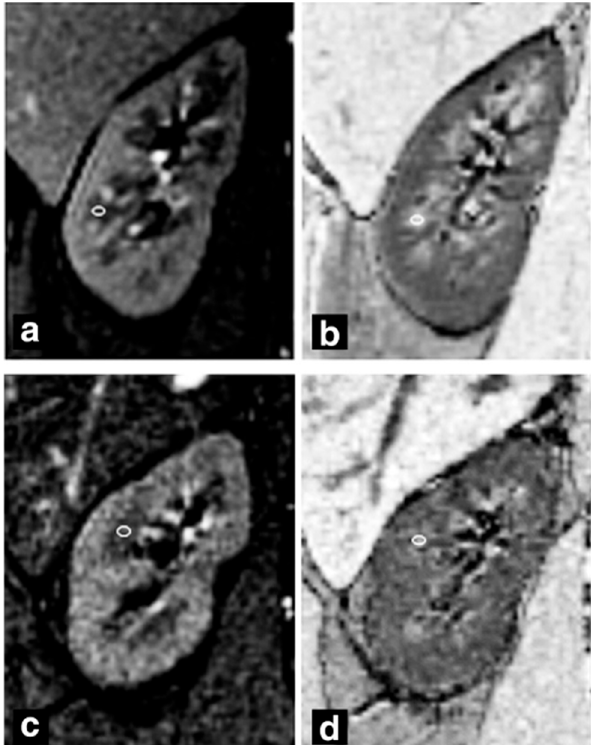
Figure 2. Representative BOLD MRI images of healthy and diabetic nephropathy patients. ( a,b ) Gradient-recalled-echo maps and R2* maps of a healthy patient, respectively. ( c,d ) Gradient-recalled-echo maps and R2* maps of a patient with diabetic nephropathy, respectively. There is a greater degree of contrast between the cortex and medulla of the healthy patient compared to the diabetic patient, indicating decreased mR2* values that result in reduced contrast. (Figure reprinted with permission from Wiley, from Wang et al., 2011).